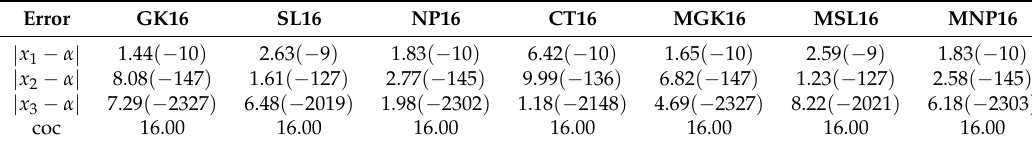
Table 4. Numerical results for f 2 , x 0 = − 0.93.